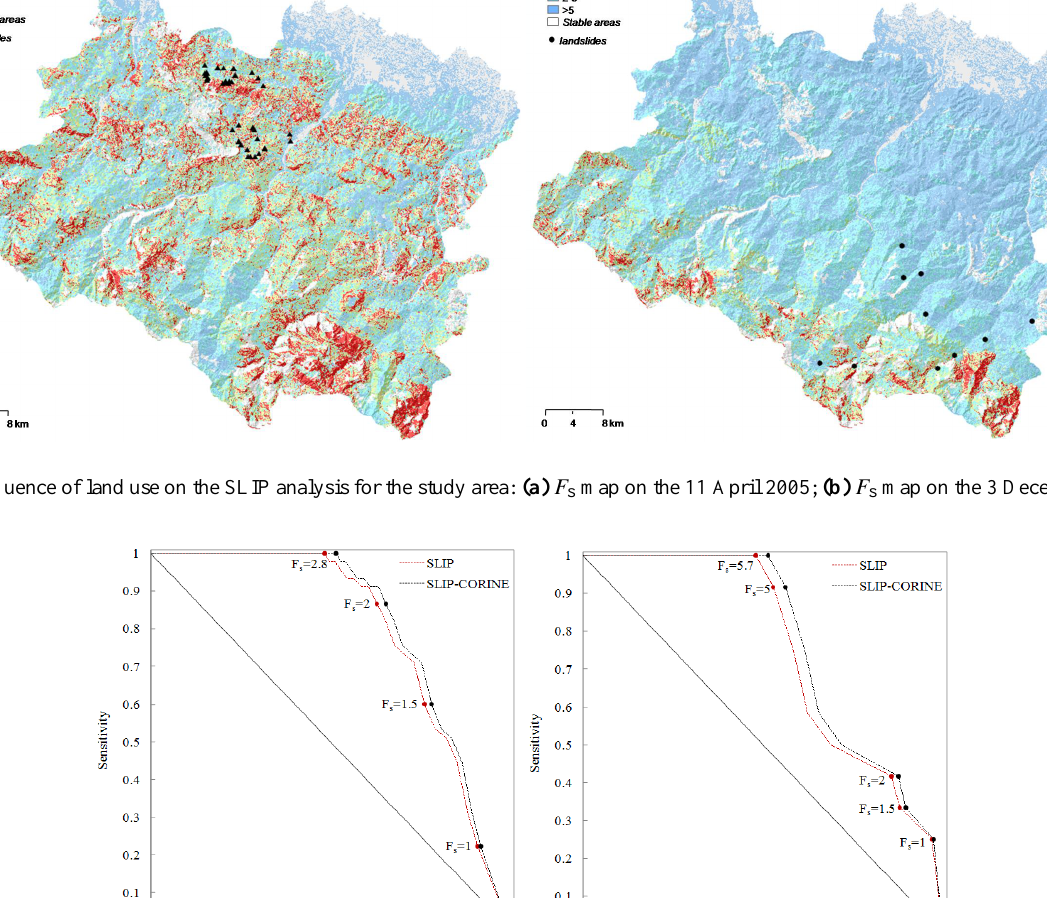
Figure 17b. Fig. 17. ROC curves representing the prediction capability of the SLIP model applied on the study area, with and without the information on